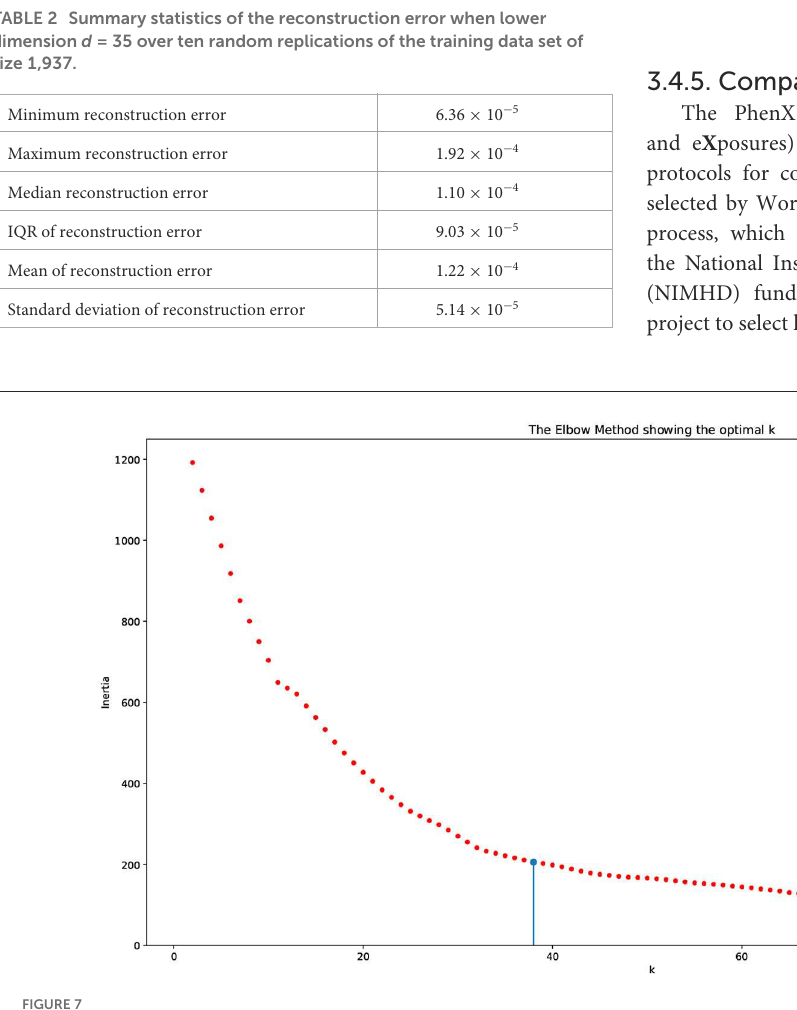
FIGURE7 Elbow plot for choosing the number of clusters. The vertical line indicates the number of clusters produced by the algorithm, which equals